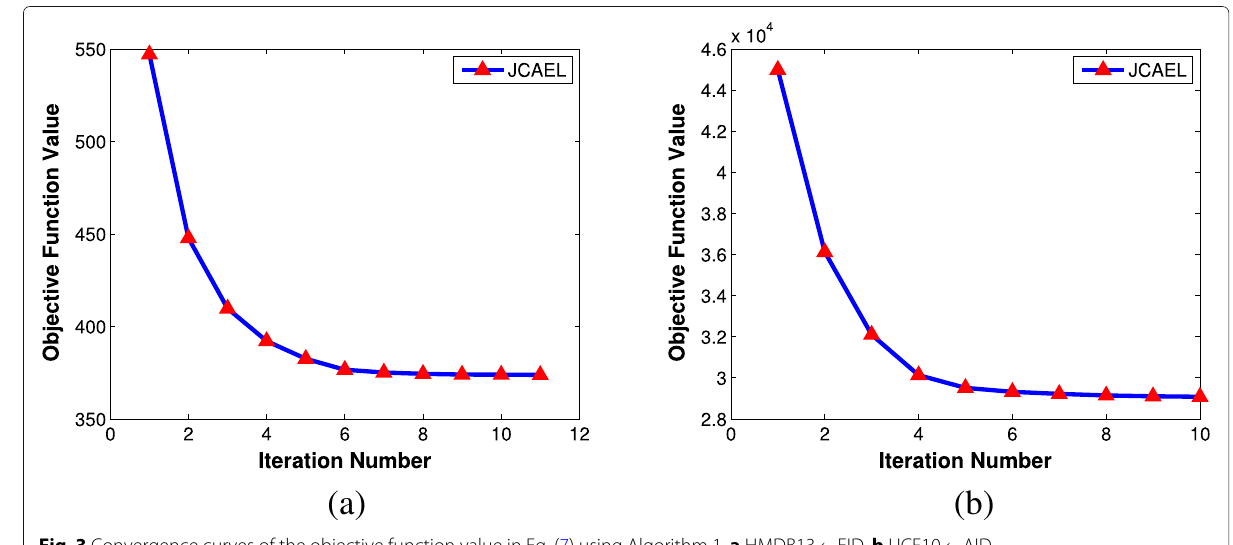
Fig. 3 Convergence curves of the objective function value in Eq. (7) using Algorithm 1. a HMDB13 ← EID. b UCF10 ← AID